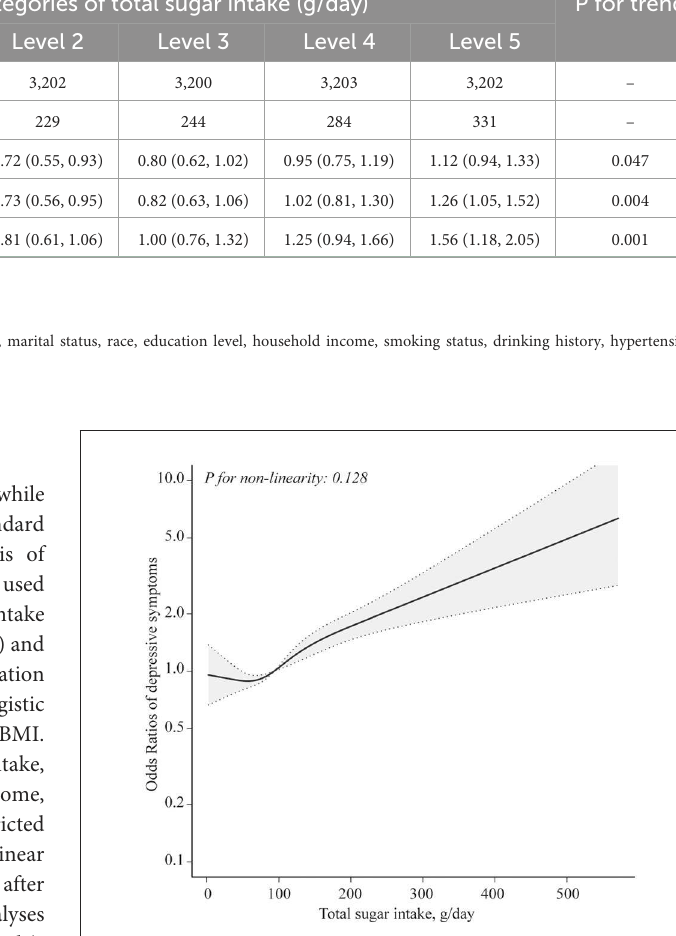
FIGURE1 Restricted cubic spline model of the odds ratios of total sugar intake with depressive symptoms. Adjusted for age, gender, BMI, total energy intake, physical activity, marital status, race, education level, household income, smoking status, drinking history, hypertension, and diabetes. The dashed lines represent the 95% confidence